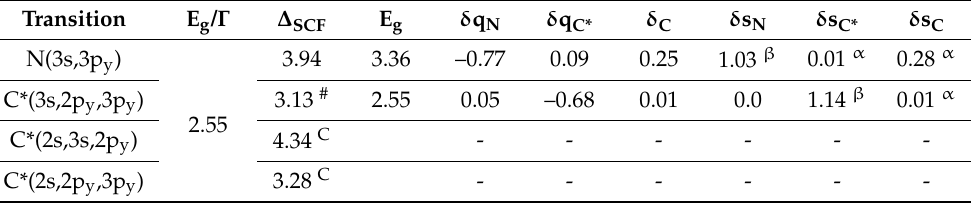
Table 7. N s − B3LYP/6-21G Γ -point gap (E g /E Γ ) and direct SCF energy ( ∆ SCF ) (eV) and changes to atomic charges ( | e | ), δ q N , δ q C* , δ q C , atomic spins ( | e | ), δ s N , δ s C* , δ s C , in N s − . α and β refer to changes in spin-up and spin-down orbitals charges and spins, respectively.